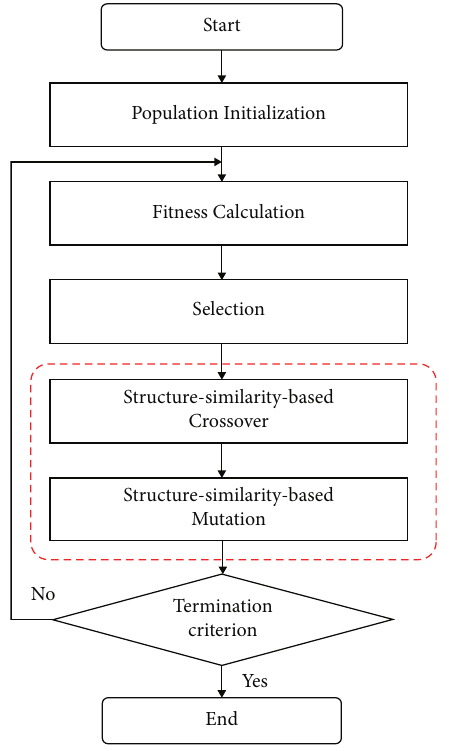
Figure 1: Framework of the GP-SS.